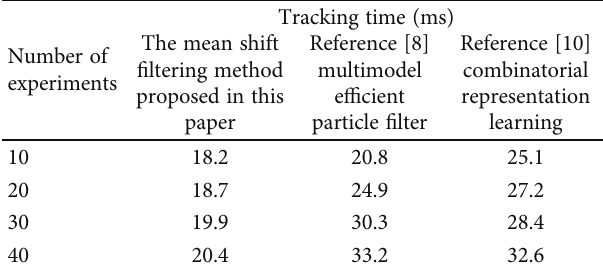
Table 3: Tracking time of di ff erent